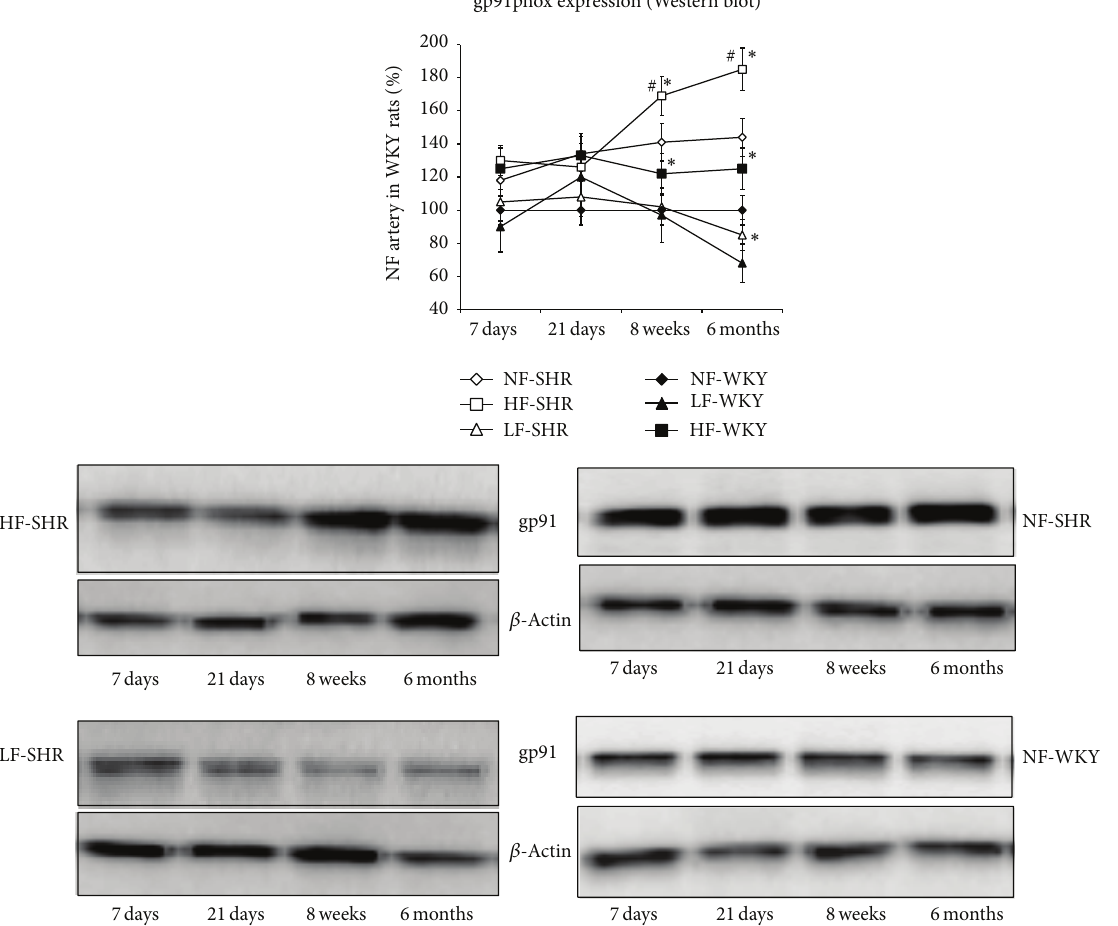
Figure 6: The NAD(P)H oxidase subunit gp91phox expression level was determined using western blot in mesenteric resistance arteries isolated from WKY rats and SHRs submitted to low flow (LF), high flow (HF), or normal flow (NF) for 1, 3, 8, or 24 weeks. Values represent mean ± SEM ( 𝑛 = 12 rats per group). ∗ 𝑃 < 0.01 , HF or LF versus NF arteries. # 𝑃 < 0.05 , SHRs versus WKY rats, within equivalent arteries (NF, LF, or